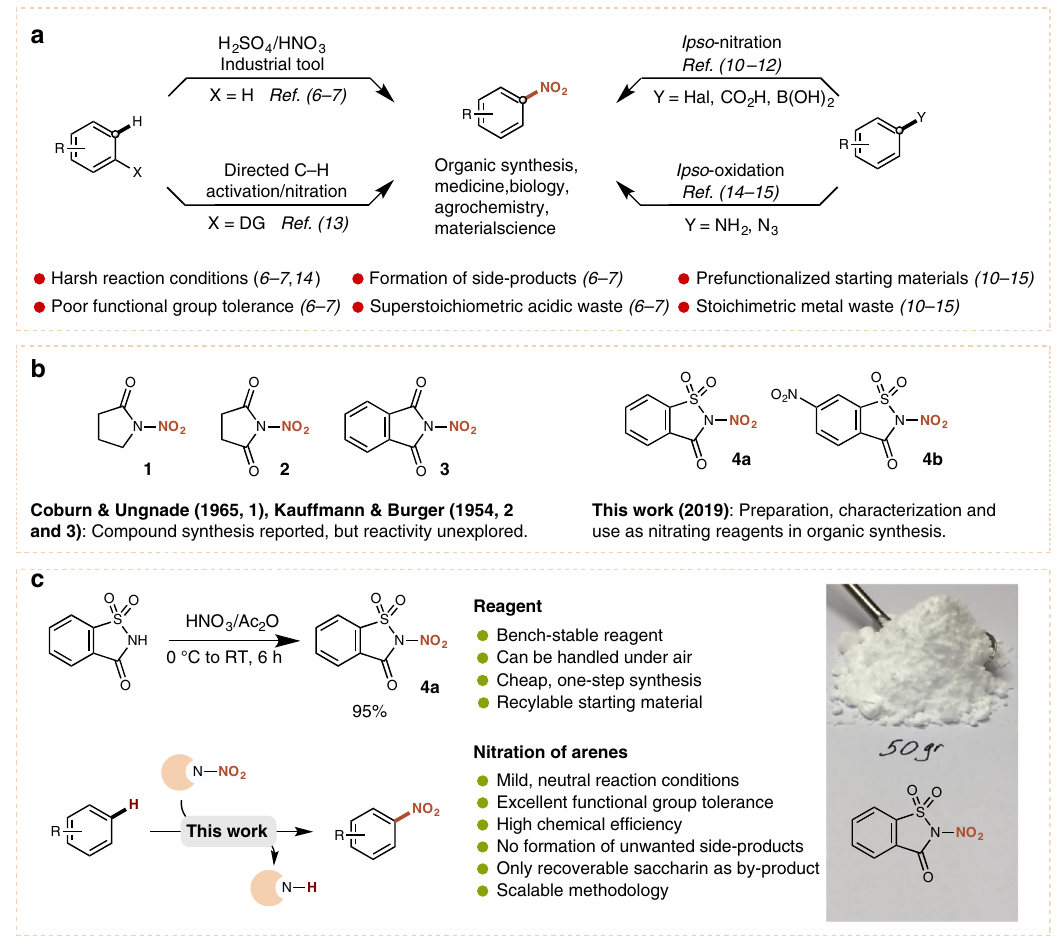
Fig. 1 Development of nitrating reagents. a Current methods to access nitroarenes. b Synthesis of a series of N – NO 2 heterocyclic compounds based on pyrrolidinone ( 1 ), succinimide ( 2 ), phthalimide ( 3 ), and saccharin ( 4 ) structures. c Our synthesis of reagent 4 and its application in the nitration of